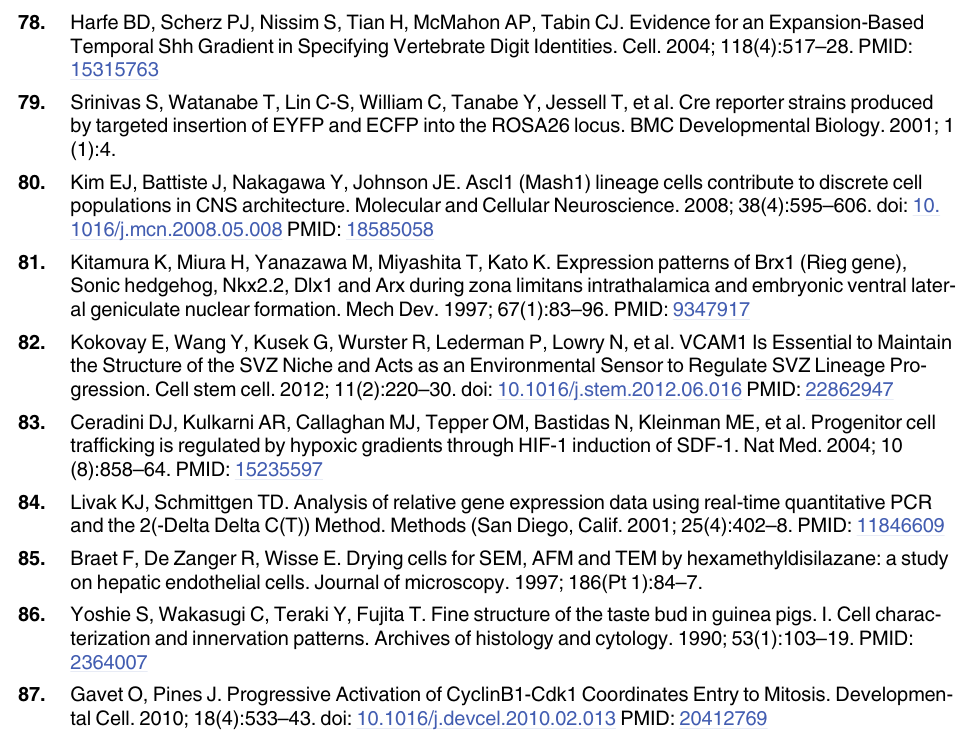
PLOS Genetics | DOI:10.1371/journal.pgen.1005208 May 28,